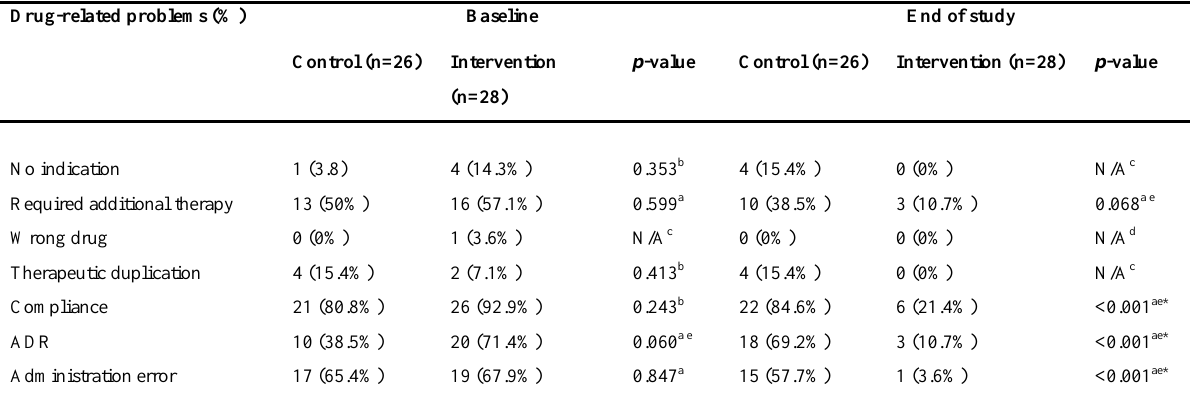
ADR, adverse drug